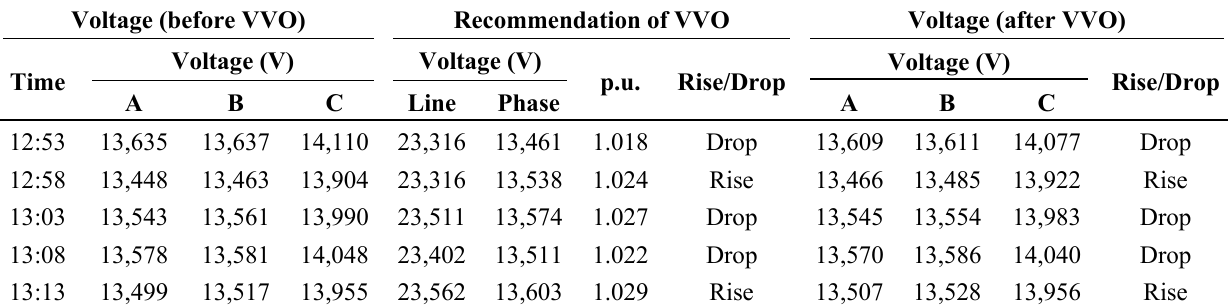
Table 10. VVO test results of periodic voltage